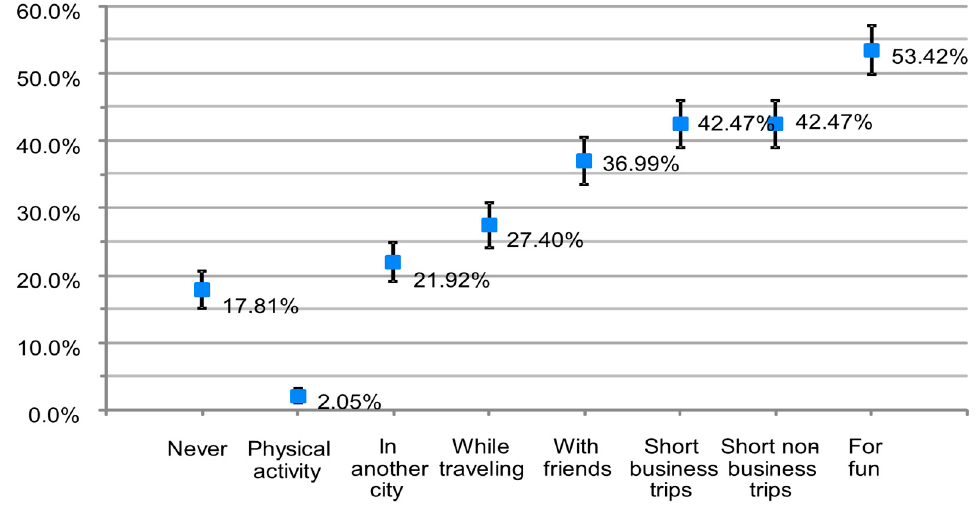
Figure 2. Frequency of respondents choosing different purposes for using e-scooter sharing services (data are presented as % ± 95% CI). (Source: generated by the authors).